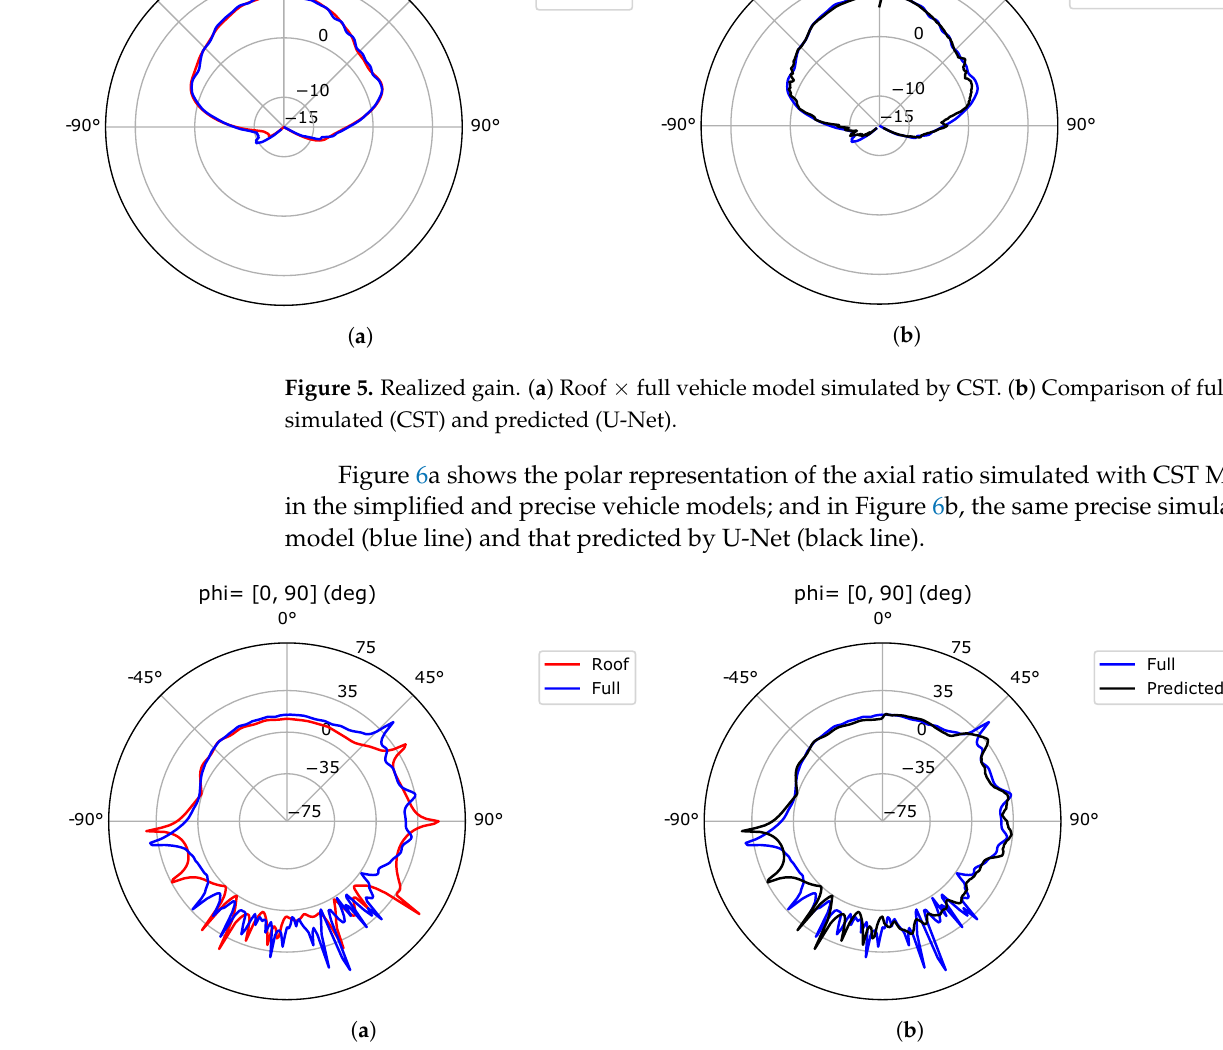
Figure 6. Axial ratio. ( a ) Roof × full vehicle model simulated by CST. ( b ) Comparison of full car, simulated (CST) and predicted